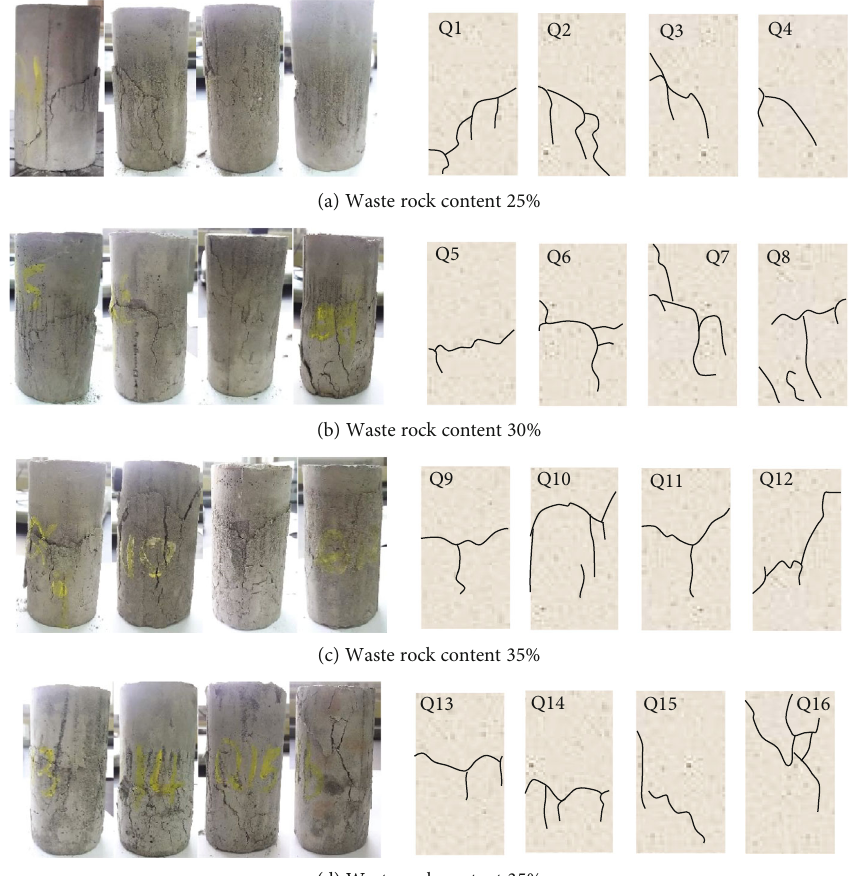
Figure 6: Damage form of back fi lls.